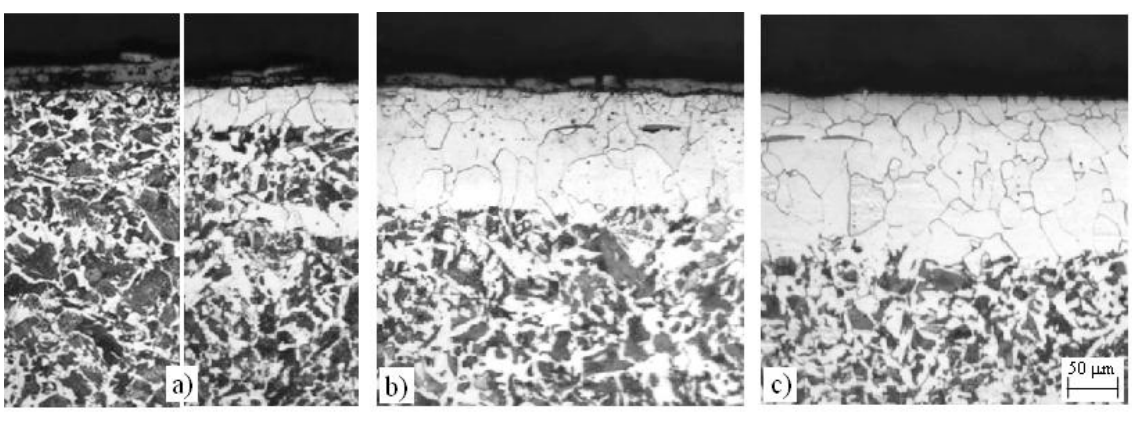
Figure 6. Microstructure of the surface part of C45 steel after annealing at T a = 760 °C. ( a ) t a = ½ h, ( b ) t a = 1 h, ( c ) t a = 2 h. ( b ) t a = 1 h, ( c ) t a = 2